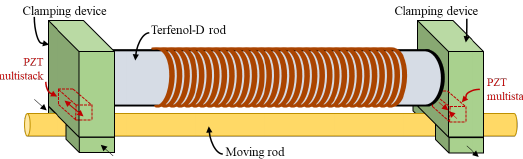
Figure 7. Sketch of the hybrid inchworm motor developed in [101,102].